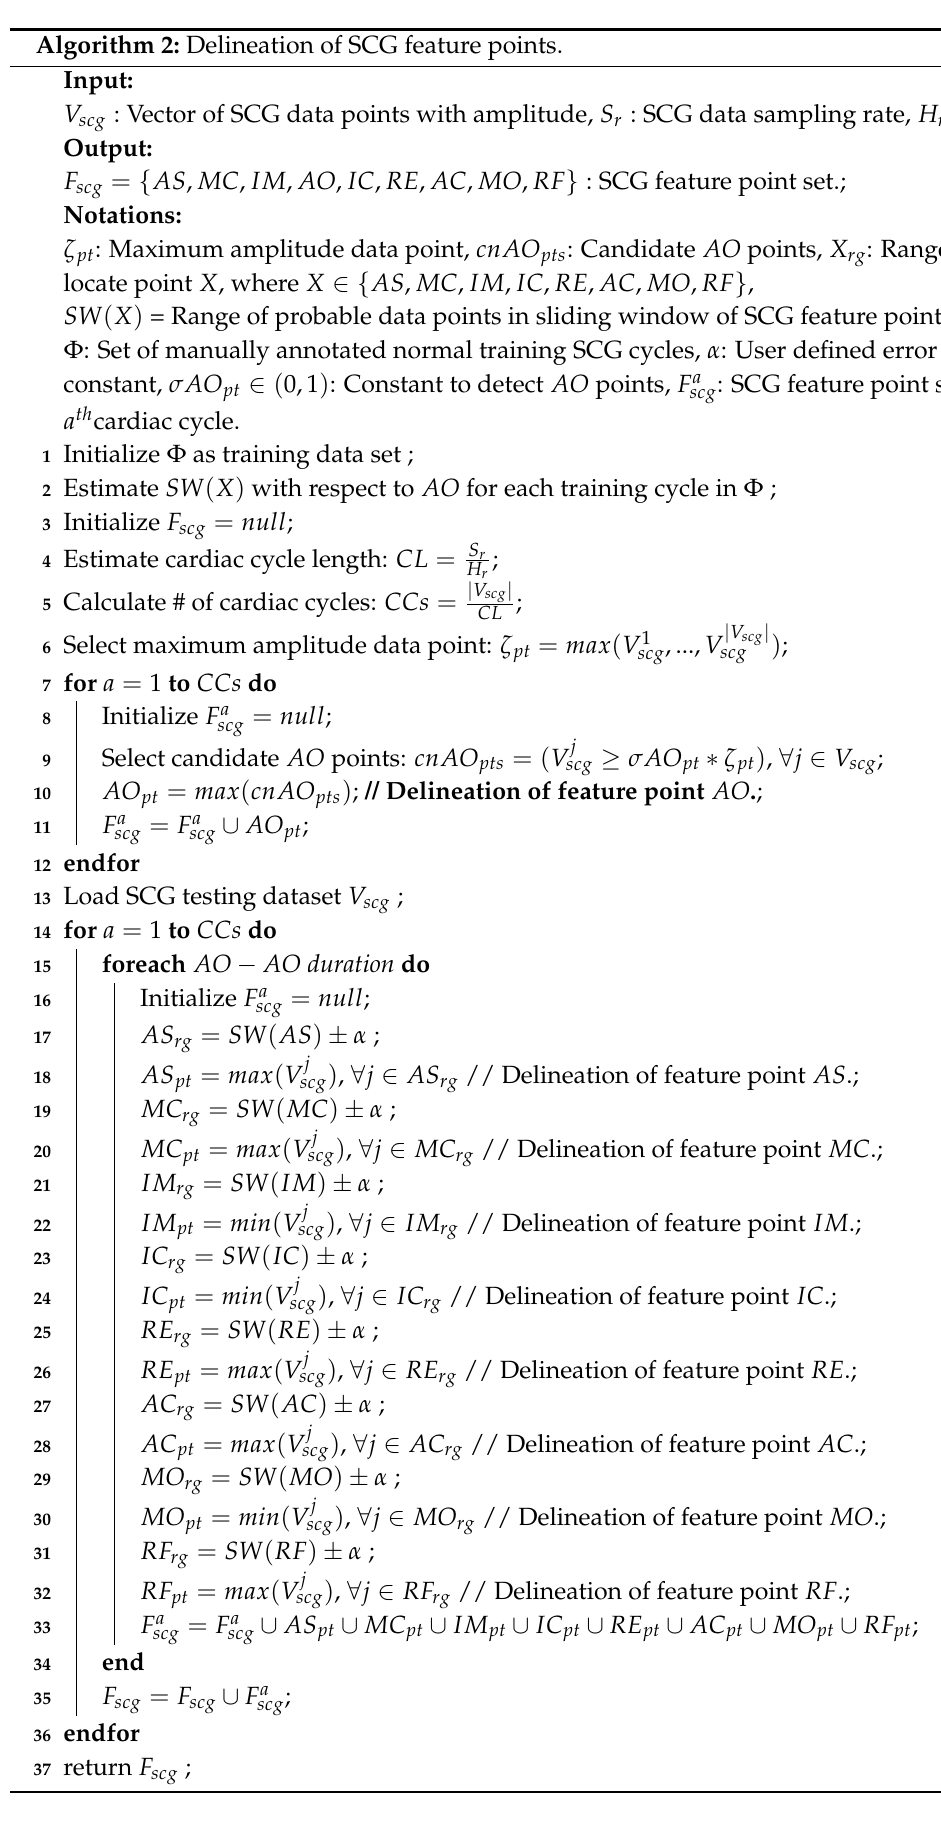
Algorithm 2: Delineation of SCG feature